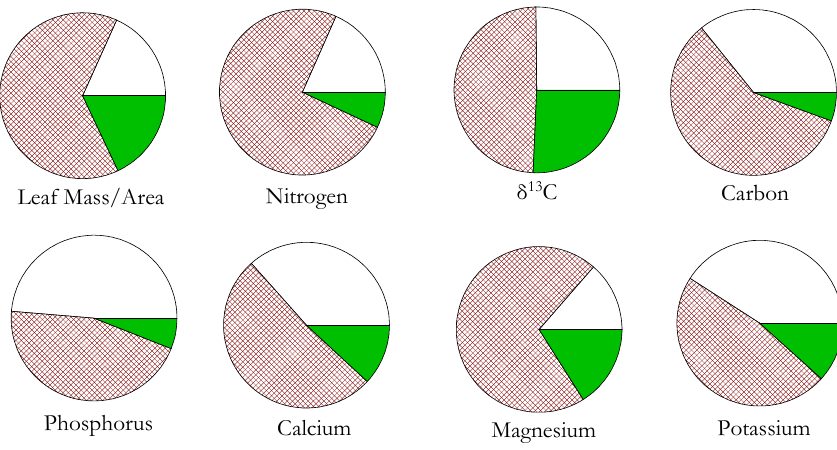
Fig. 5. Partitioning of the observed variance in the dataset according to Eq. (13). Green = variability with height within individual trees; purple hatches; variability between trees within individual plots; white = variability between